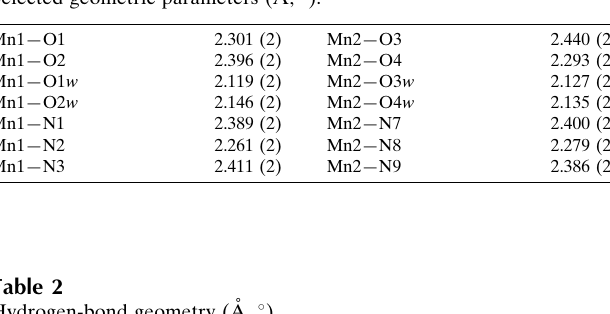
Selected geometric parameters (A˚ , (cid:2) ).